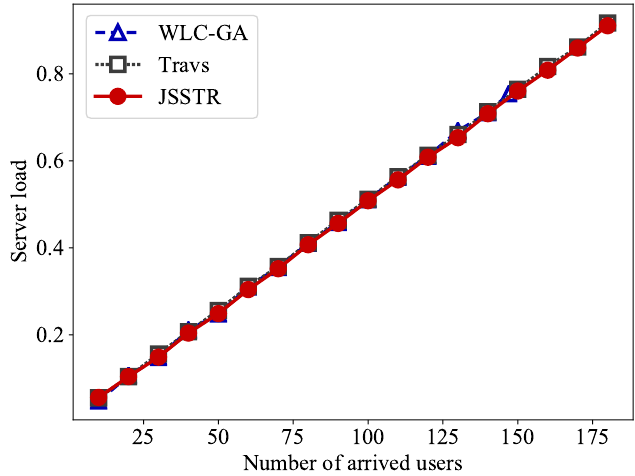
Figure 8. Server load comparison for JSSTR, Travs and WLC-GA.